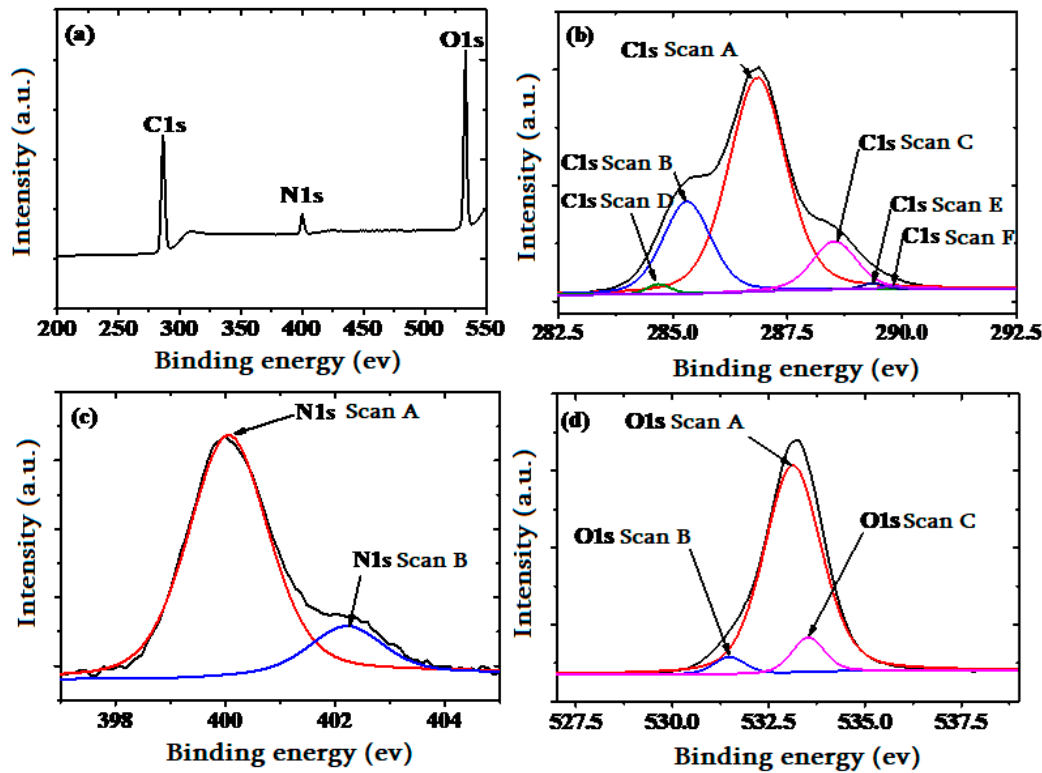
Figure 10. XPS spectra of the ( a ) survey scan, ( b ) C1s, ( c ) N1s, and ( d ) O1s, peaks for the single-layer chitosan-PEG blend thin film